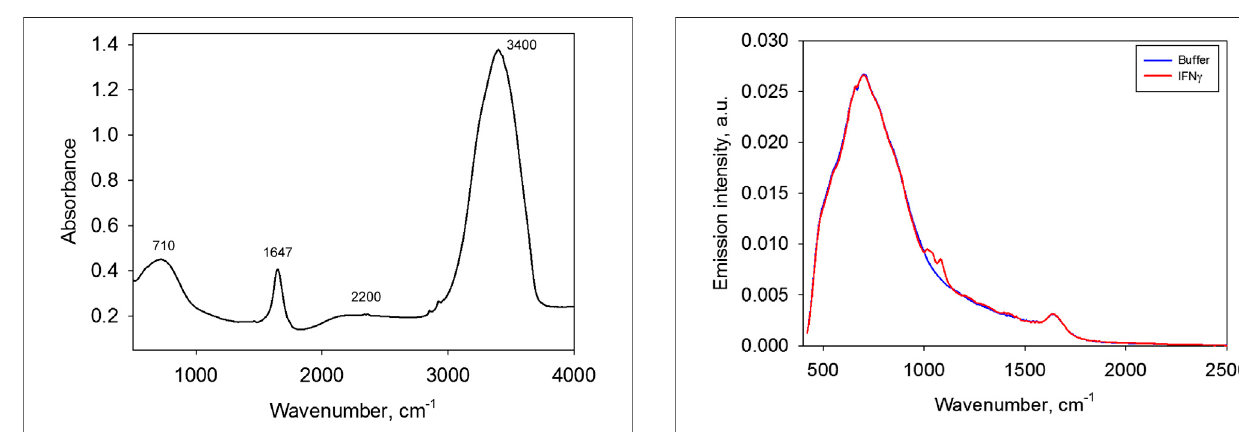
FIGURE 6 | The water absorption spectrum at 25 ° S